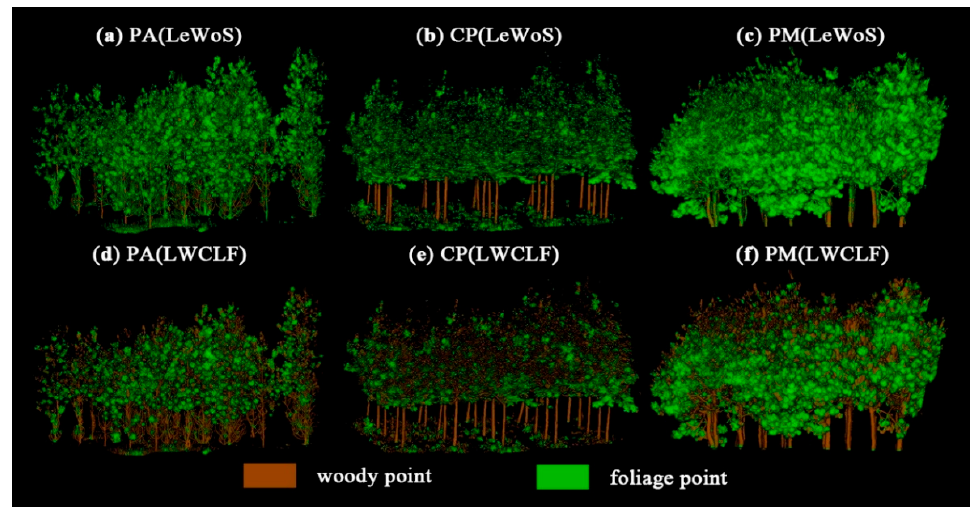
Figure 8. The foliage–wood separation results obtained using the LeWoS and LWCLF models. The subfigures ( a ) to ( c ) show the separation results of woody and foliage points by using the LeWoS model. And the subfigures ( d ) to ( f ) show the classification results of woody and foliage points by using the LWCLF model.